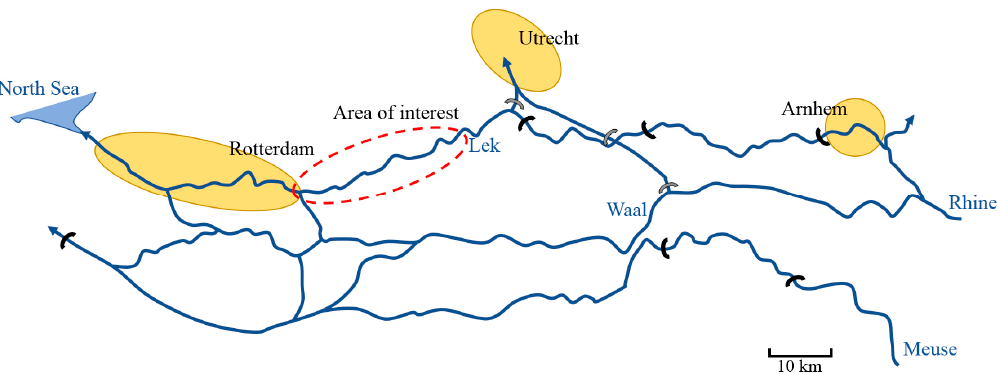
Figure 1. The Rhine–Meuse delta and the location of the area of interest. River flow on the Lek can be controlled by the three weirs in the river. Major cities are depicted by the yellow ovals.